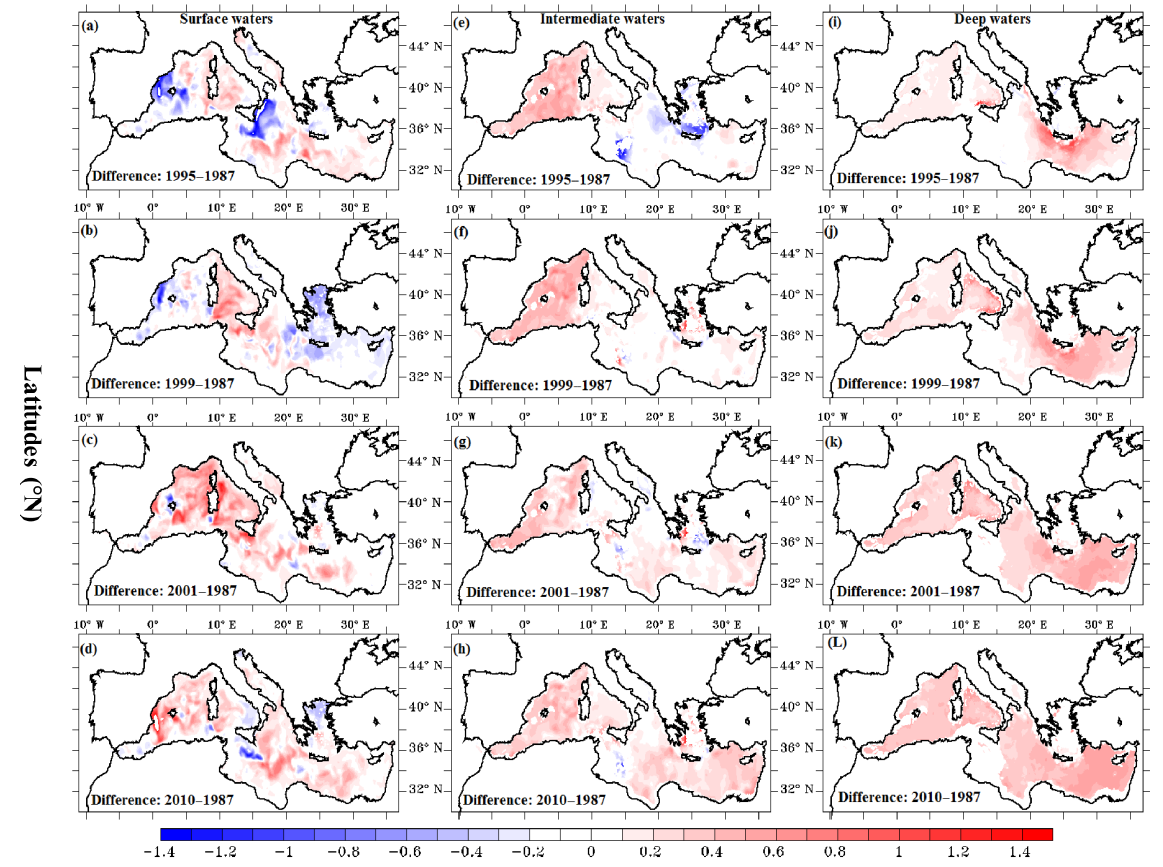
Figure 8. Horizontal maps showing the difference relative to 1987 from EXP2 ( τ = 3 month), in the left column for the surface level (0– 200m), in the middle column for the intermediate layer (between 250–600m, and for the deep layer in the right column